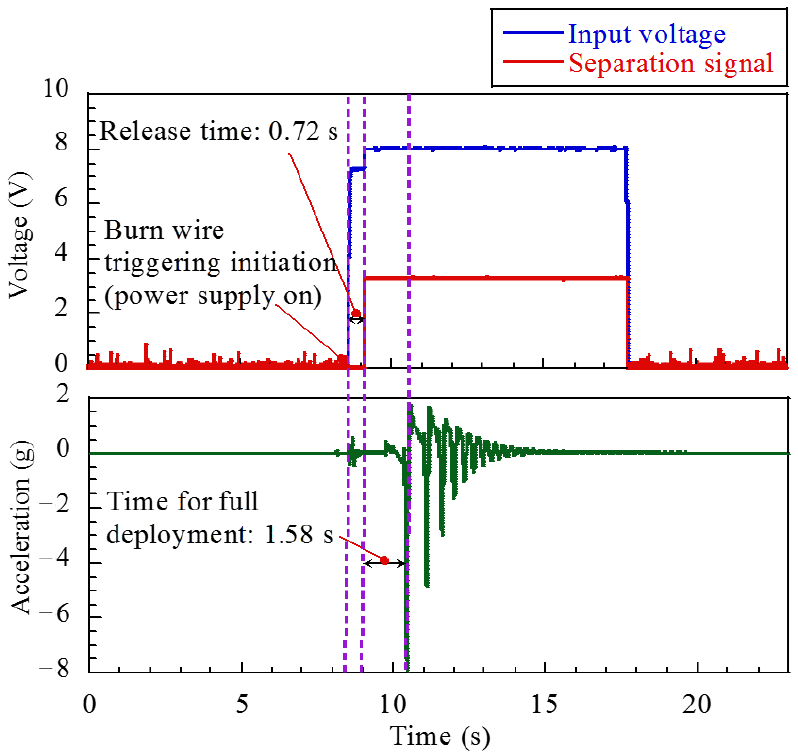
Figure 11. The solar panel’s deployment test results.